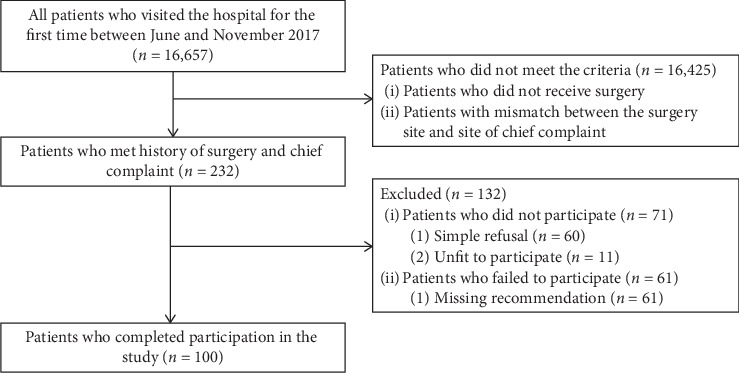
Flowchart of the study.